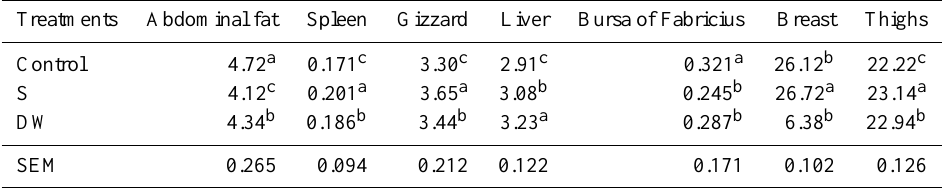
Table 6. The effect of sumac and whey powder diets on carcass traits (%) of female broiler chicks. Treatments Abdominal fat Spleen Gizzard Liver Bursa of Fabricius Breast Thighs Control 4.72 a